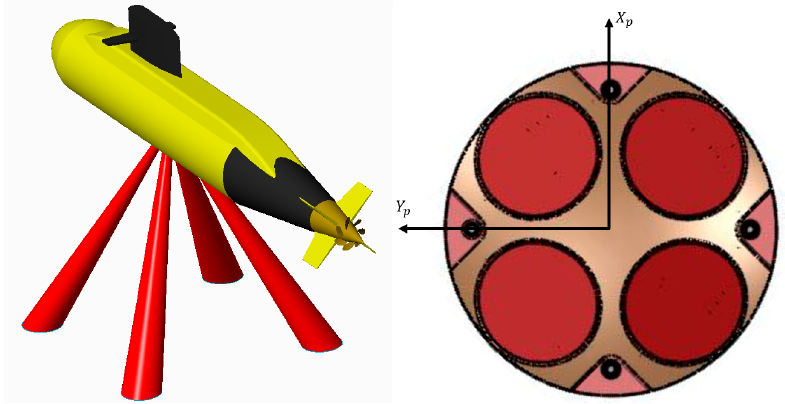
Figure 5. DVL orientation setup in the TAUV platform frame.